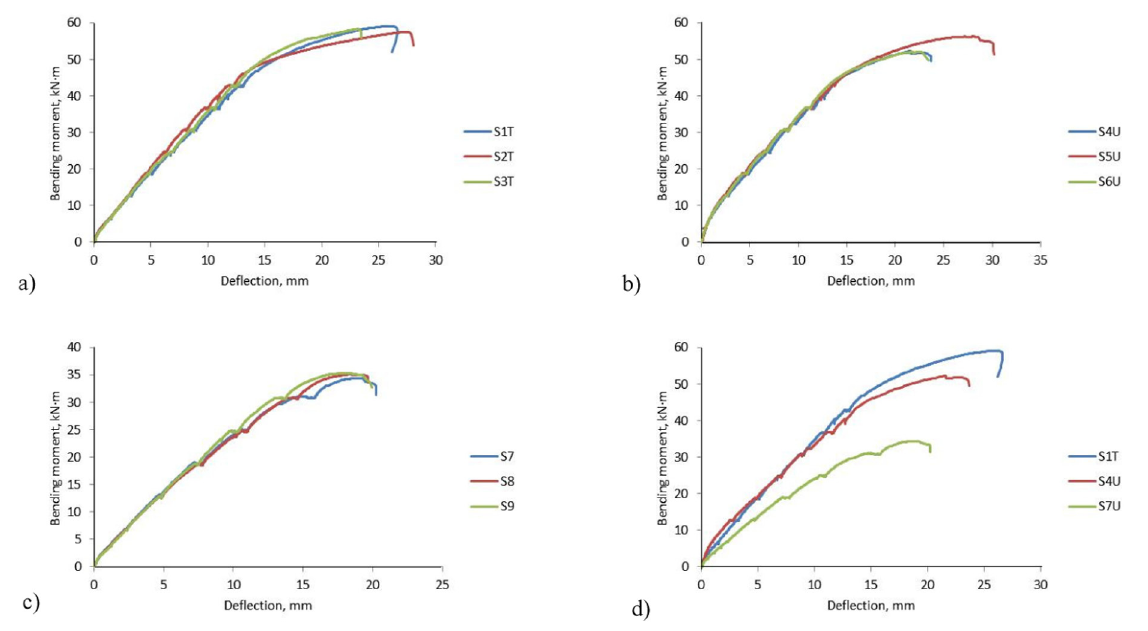
Fig. 15. Experimentally predicted deflections: (a) S1T, S2T, and S3T beams, (b) S4U, S5U, and S6U beams, (c) S7, S8, and S9 beams, (d) comparison of experimentally predicted deflection of the S1T, S4U, S7